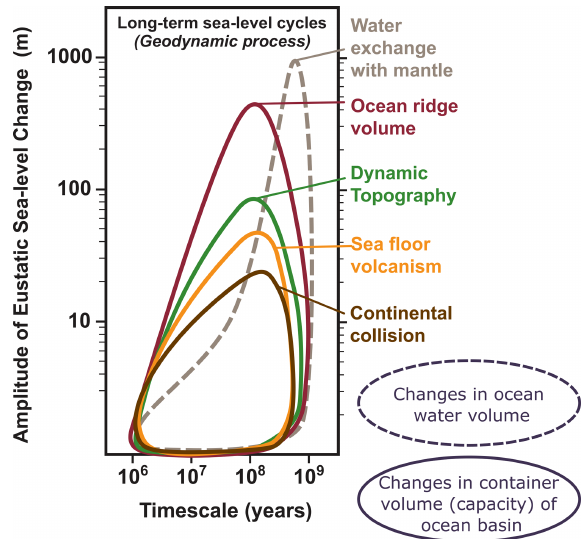
Figure 13. Log-scale diagram of the timing and amplitudes of the main mechanisms that control “long-term” sea-level variations related to internal geodynamic processes. The values represented must be considered the average (modified from Sames et al.,